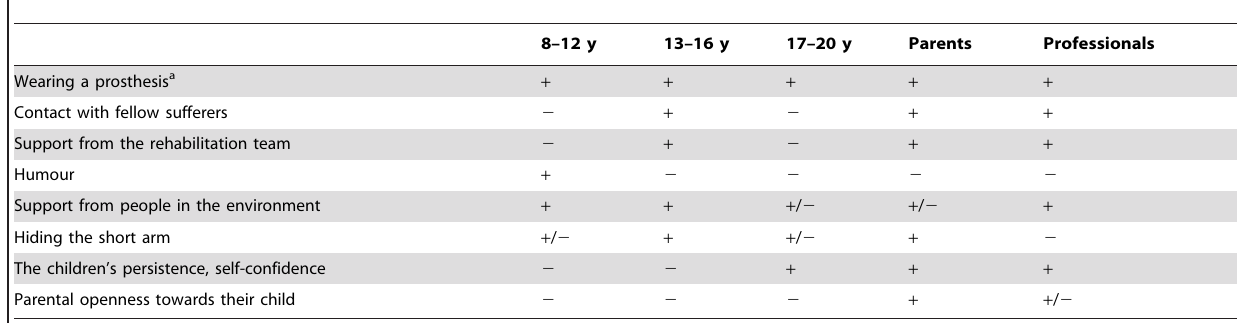
Table 2. Things that help children/adolescents with UCBED to cope with the